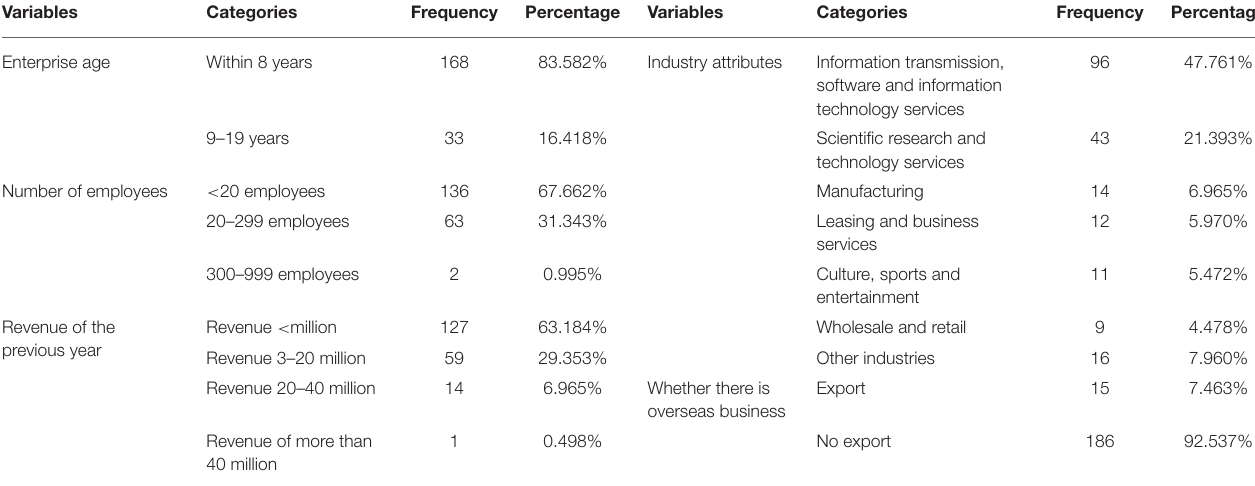
TABLE 1 | Characteristics of valid